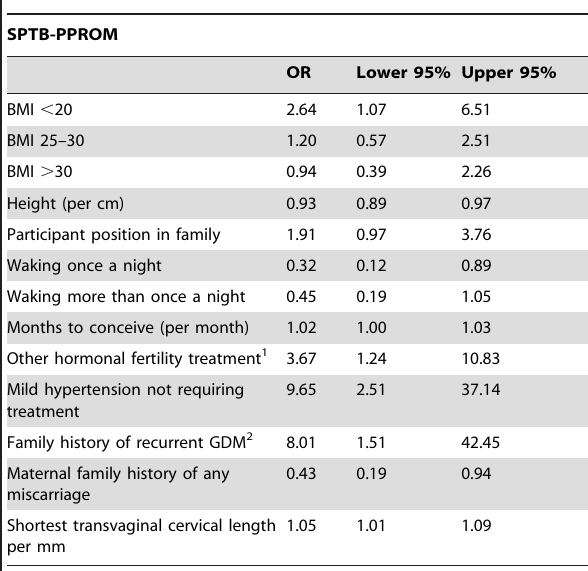
Table 3. Clinical risk factors at 15 weeks, and ultrasound scan variables at 20 weeks in logistic regression model for SPTB-